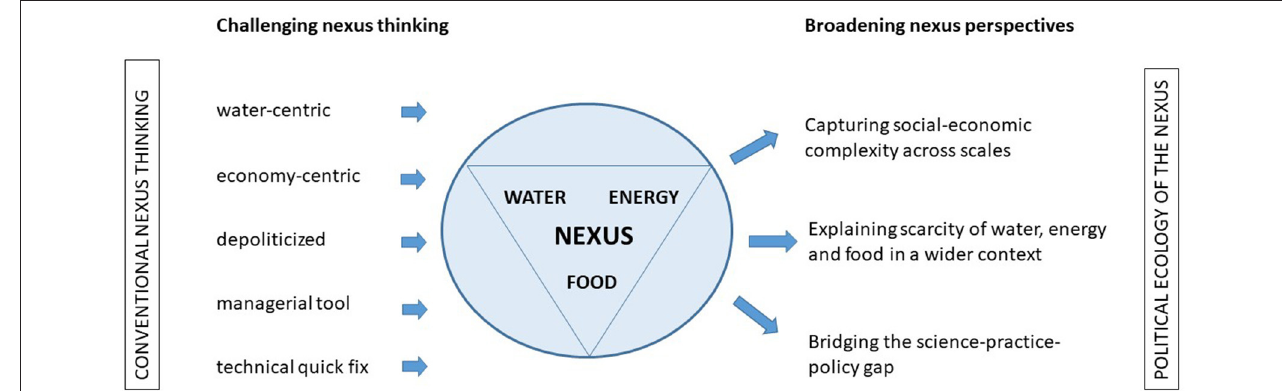
FIGURE 2 | From challenges of nexus thinking to broadening nexus